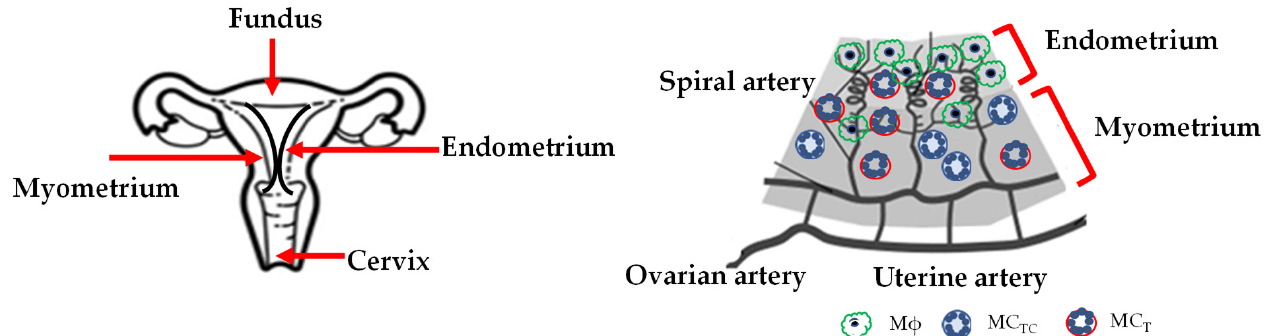
Figure 4. Schematic picture of the cycling non-pregnant human uterus with endometrium and myometrium tissue, and M ϕ s, MC T , and MC TC localization under physiological conditions. Abbreviations: Mast cells tryptase (MC T ), Mast cells tryptase, chymase (MC TC ). This figure was generated using BioRender and modified in PowerPoint.